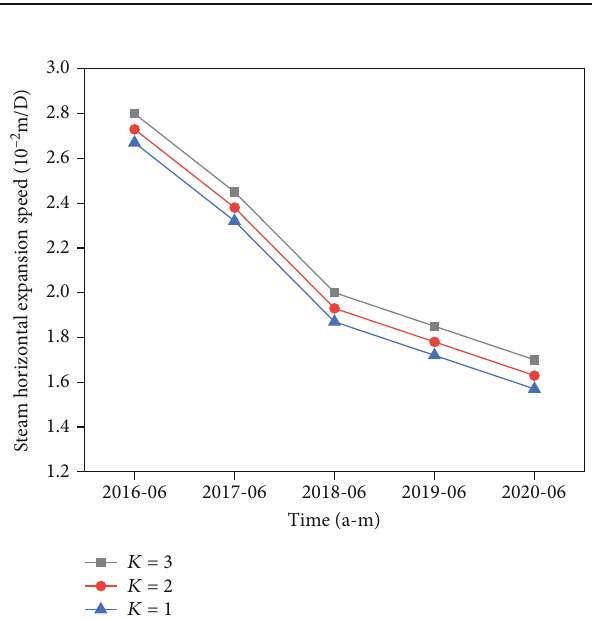
Figure 8: Schematic of the lateral expansion speed of the steam chamber under di ff erent thermal conductivities.